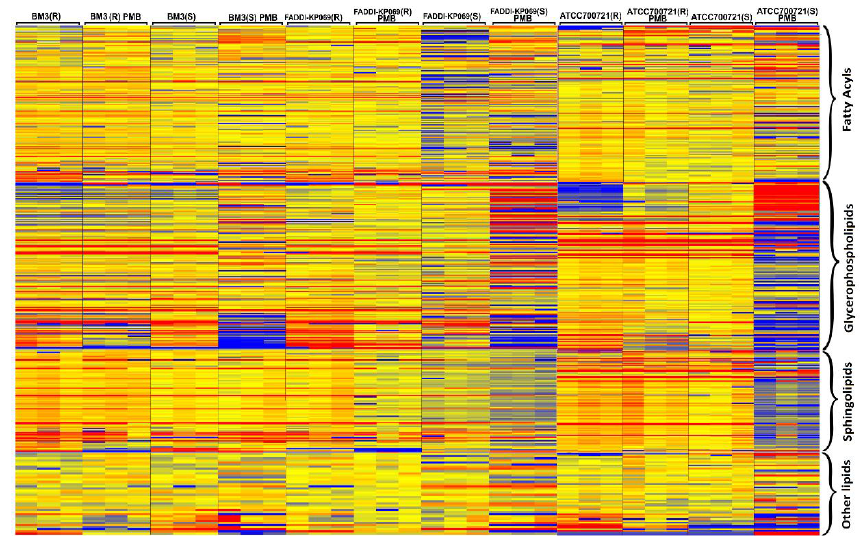
Figure 2. The heat map illustrates the relative peak intensity of lipids within each class in the OMVs of the paired polymyxin-susceptible and -resistant K. pneumoniae isolates. (R) = polymyxin-resistant; (S) = Polymyxin-susceptible. Colours indicate relative abundance of lipidomes based on the relative peak intensity (red = high, yellow = no change, blue = undetectable).